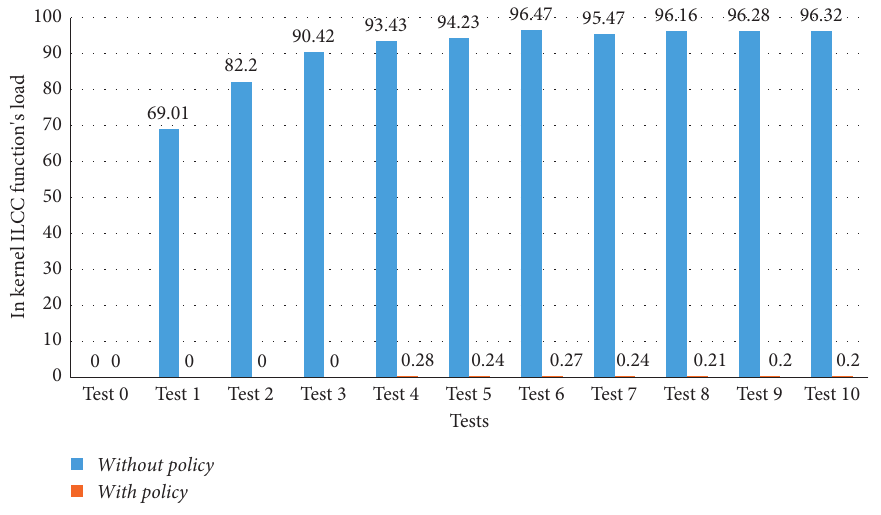
Figure 16: In kernel ILCC function’s